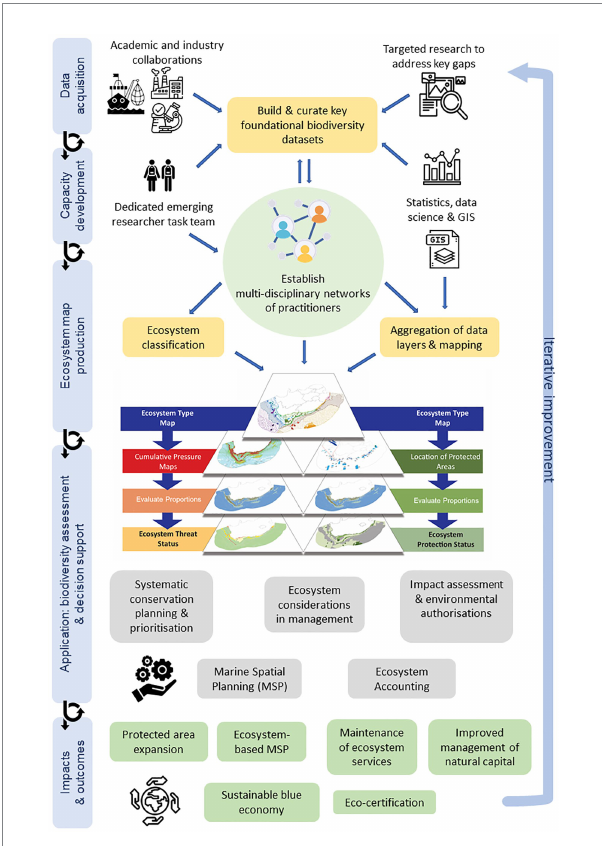
FIGURE 6 Schematic illustrating the iterative and collaborative process to develop and apply a national marine ecosystem map, demonstrating the flow of biodiversity data and decision support across the biodiversity value chain. For ecosystem threat status and protection level, the proportion of each ecosystem type in good condition and within the MPA network were evaluated against a series of ecosystem condition and representation in protected area network thresholds, respectively. See Sink et al. (2019) for assessment